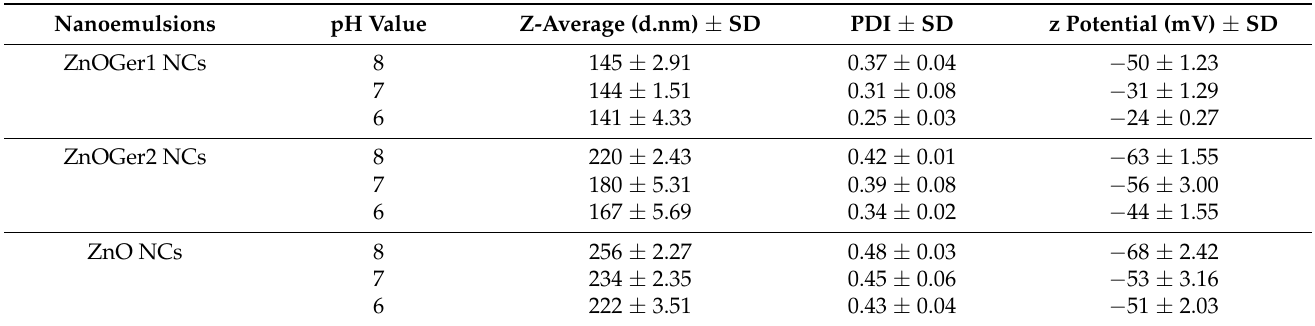
Table 1. Hydrodynamic size (z-average; d.nm), ζ -potential (mV), and polydispersity (PDI) values of ZnOGer1 NCs, ZnOGer2 NCs, and ZnO NCs at pH values 6, 7, and 8. The analyses were performed in triplicate (n = 3; mean value ± SD).